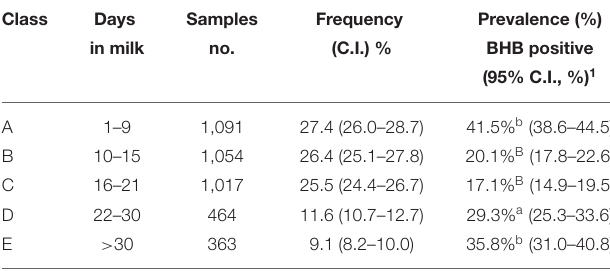
TABLE 1 | Description of sample frequencies by days in milk and relative BHB